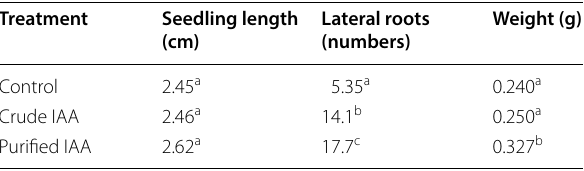
Different superscripts (a, b, c) show statistically significant difference ( P < 0.05) between rows